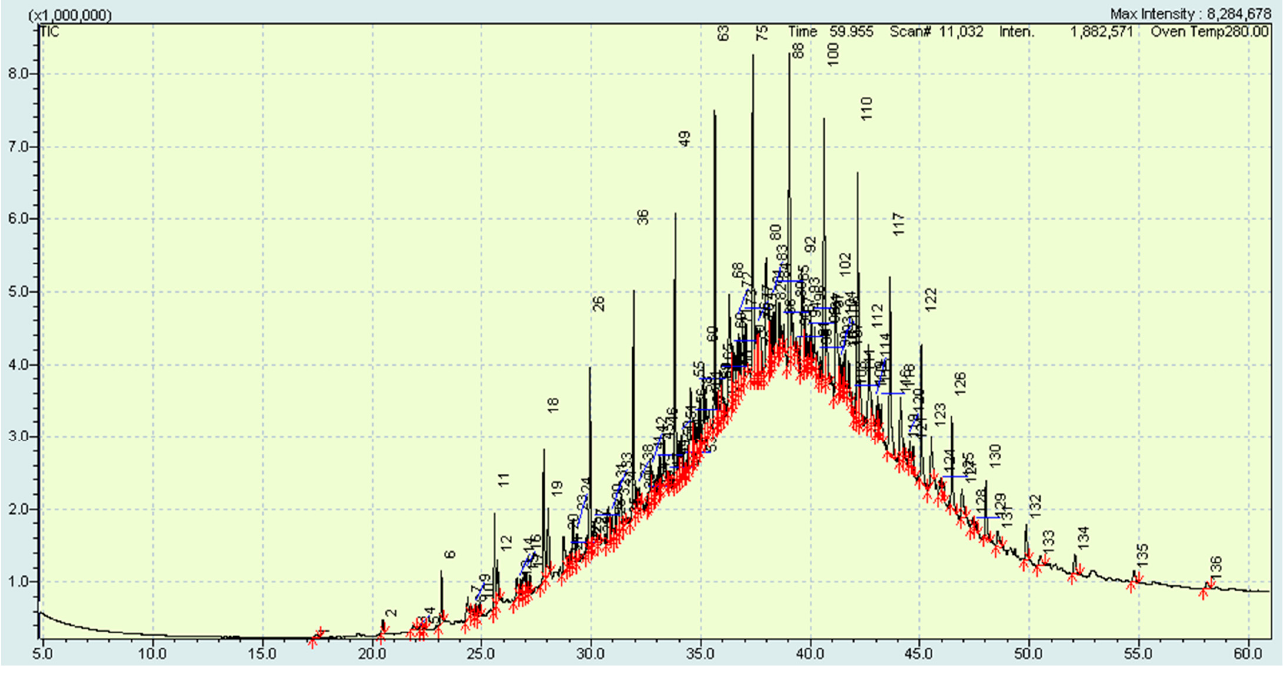
Figure 7. Chromatogram of sediment from residual fuel mixture No.1. Table 6. The group composition of the sediment of the residual fuel mixture No.1. Group Composition